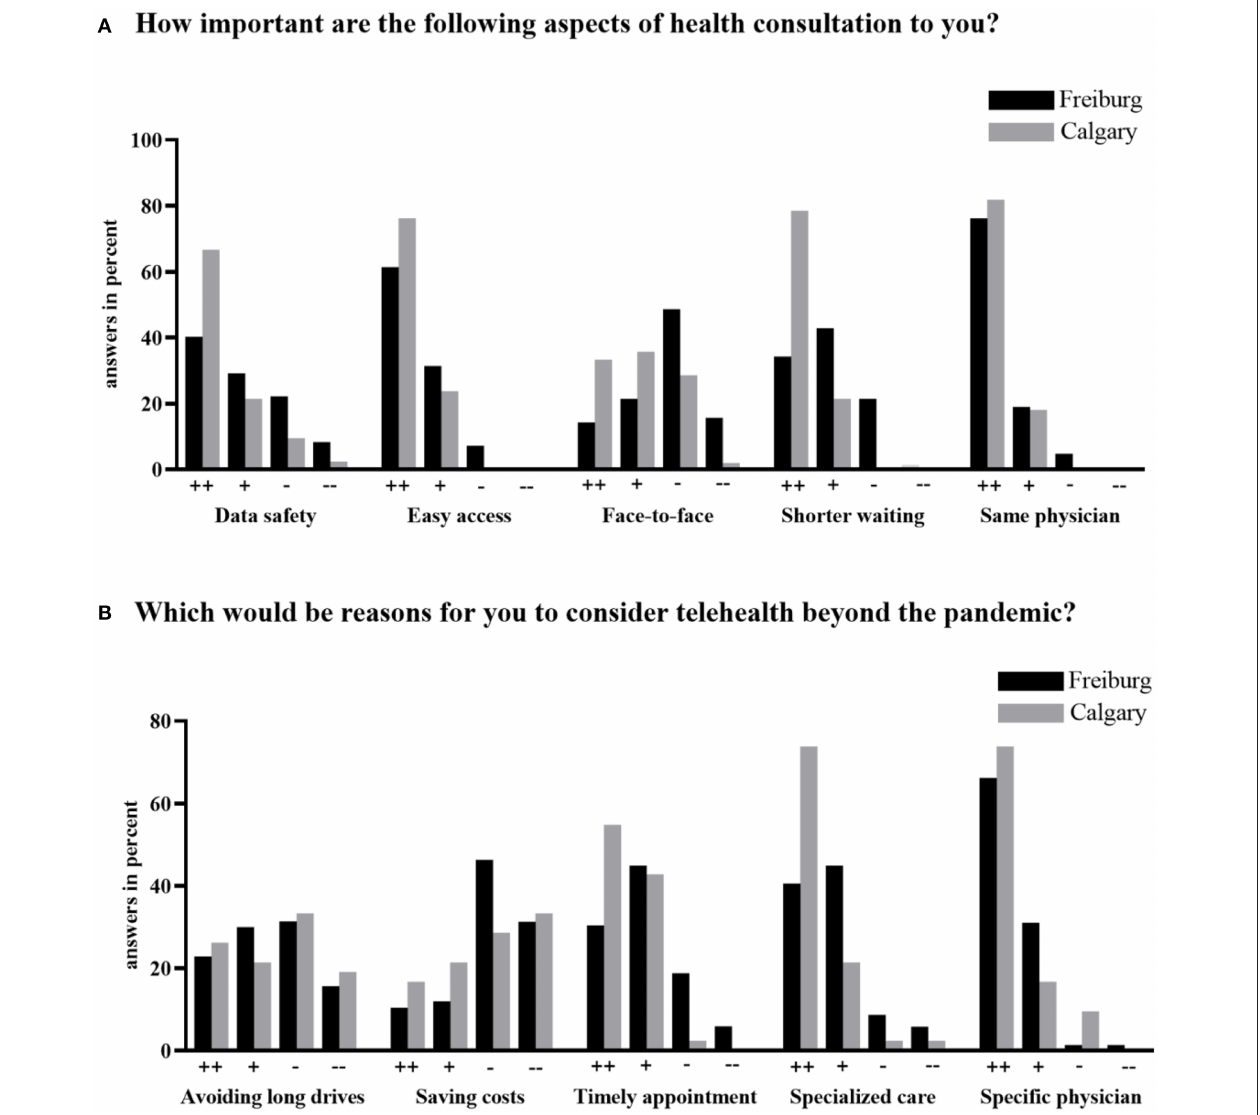
FIGURE 2 | Importance of health consultations in general (A) and reasons to consider telehealth beyond the time of the pandemic (B) reported by families in Freiburg, Germany ( n = 72) and Calgary, Alberta, Canada ( n = 42).